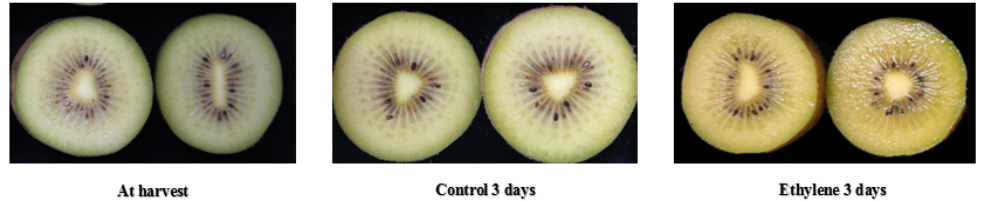
Figure 7. Gold ‘Haegeum’ kiwifruit at harvest and after 3 days of ripening with ethylene treatment or without ethylene treatment (control) at 25 °C.